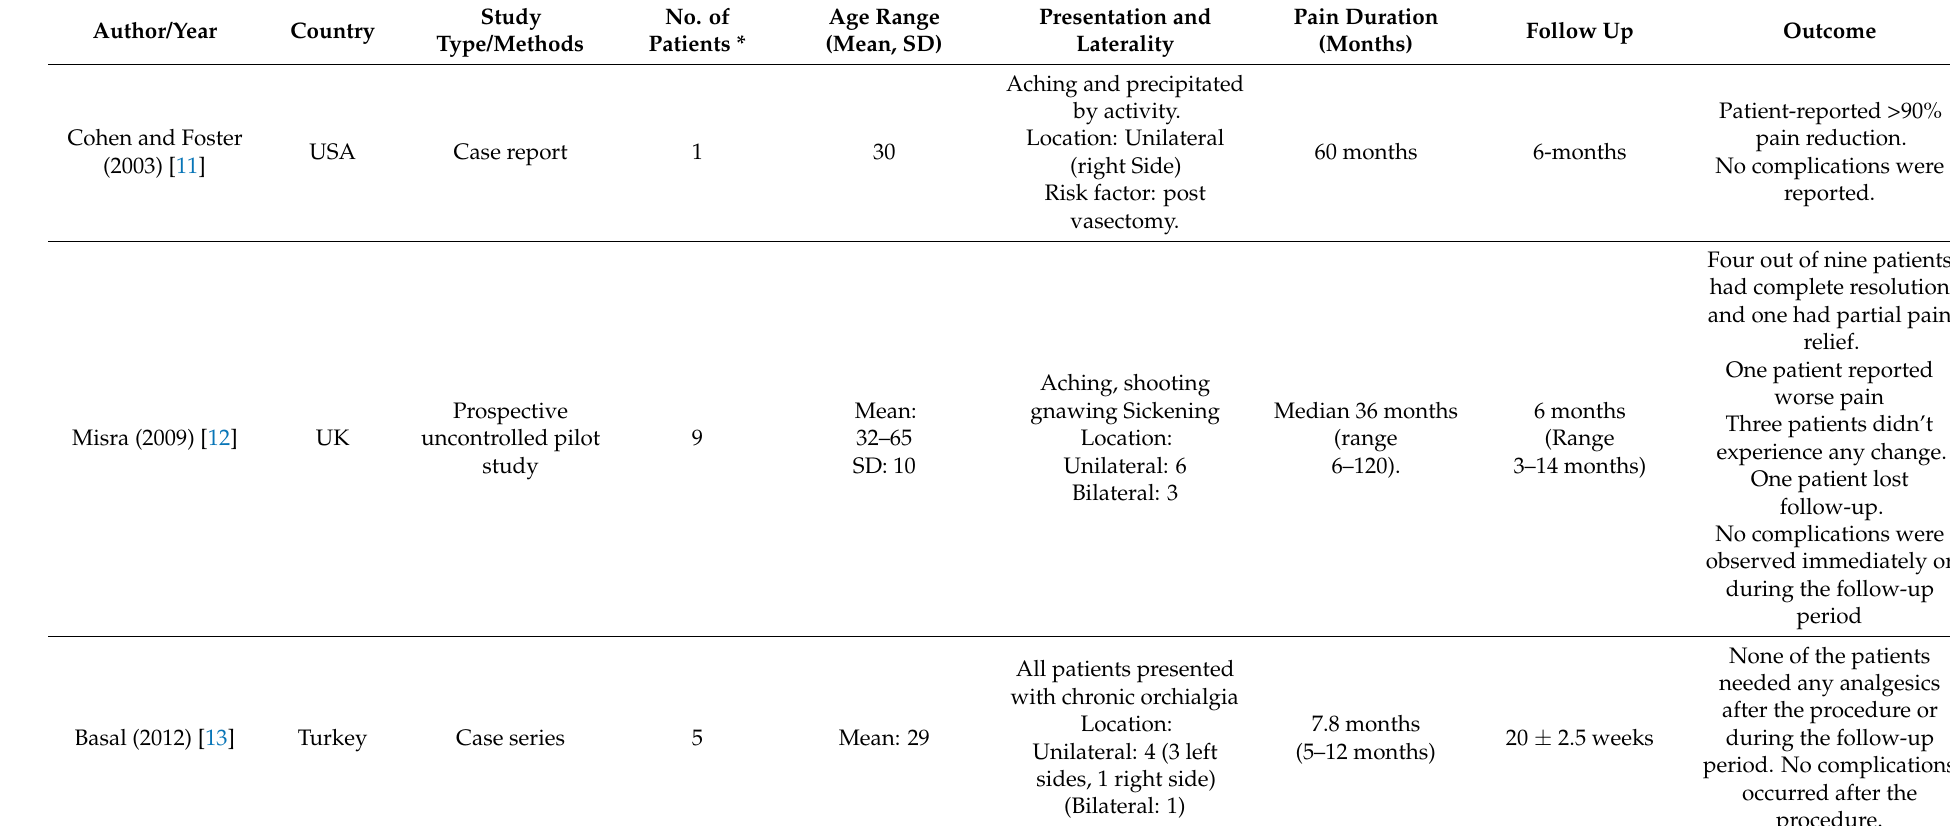
Table 2. Summary of study and patient characteristics who undergo pulsed radio-frequency therapy for